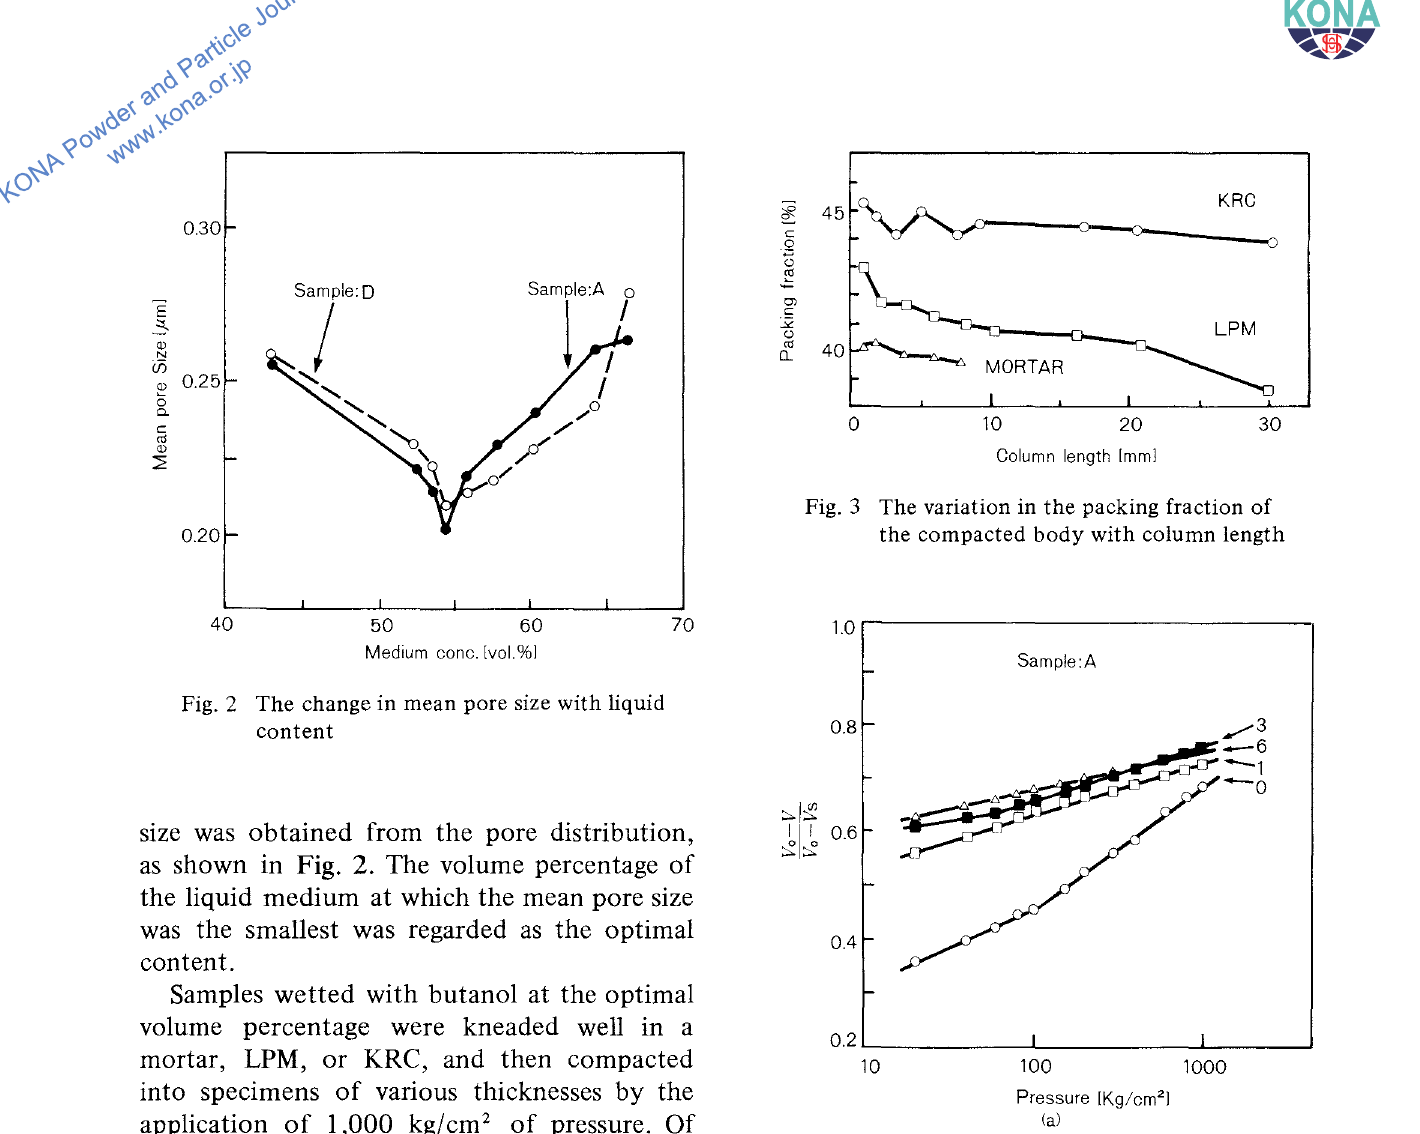
Fig. 2 The change in mean pore size with liquid content